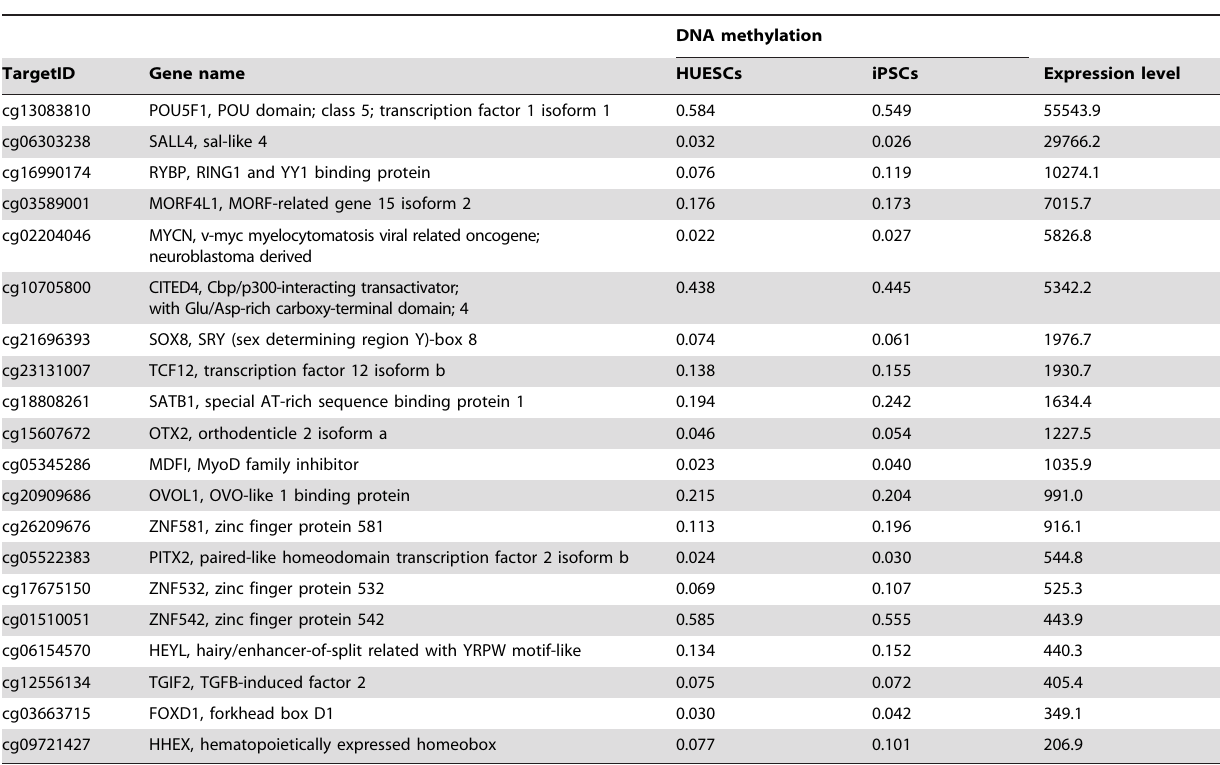
Table 1. List of the top 20 out of 82 transcription factor genes with hypo-methylated stem cell-required DMRs exhibiting ‘‘high’’ expression in human iPS